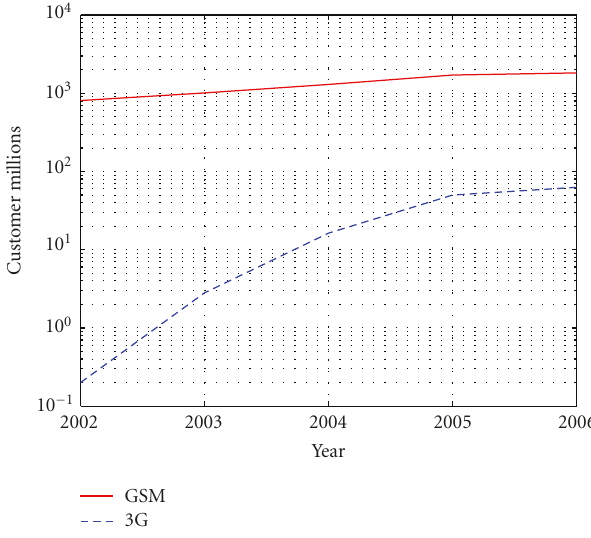
Figure 1: GSM and 3G customer evolution (millions).